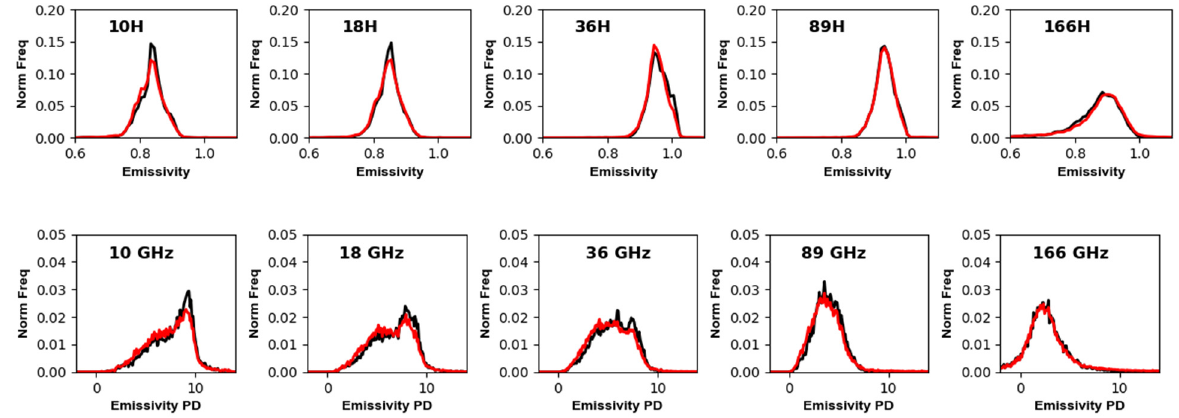
Figure 15. Same as Figure 14, but for profiles over lightly vegetated surface cover.